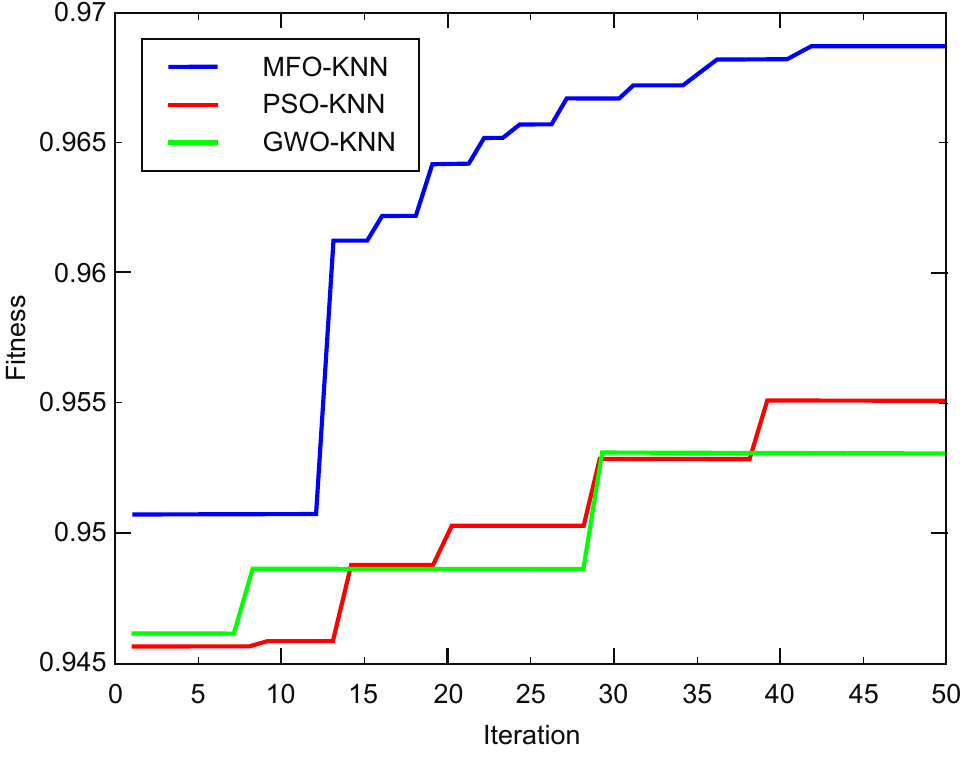
Figure 5. Fitness curve of 8000 data sets.